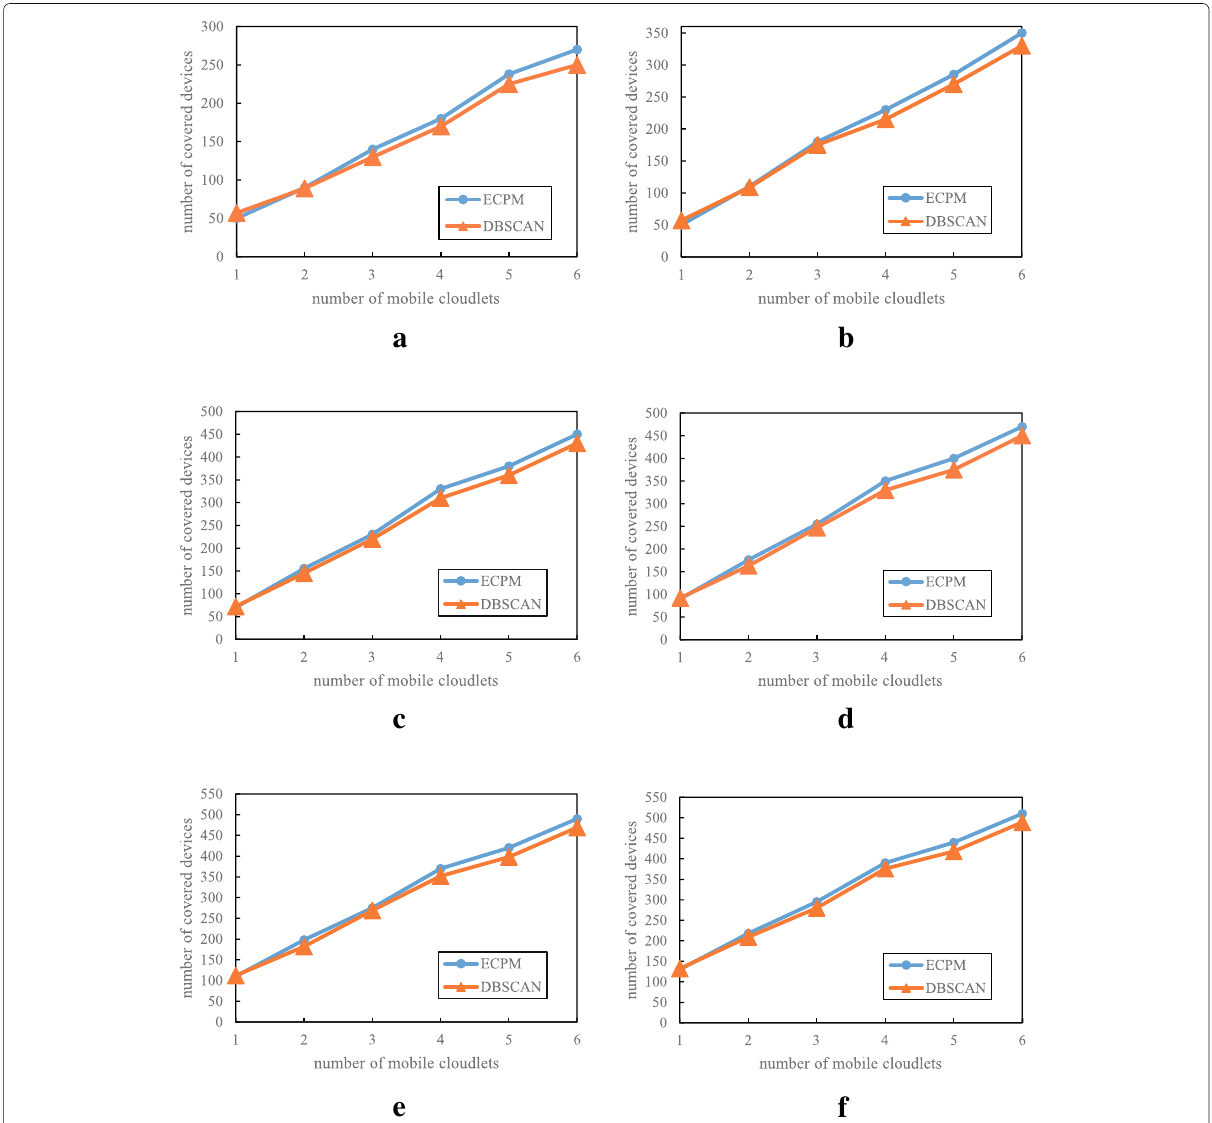
Fig. 5 Comparison of the covering equipment between the ECPM and DBSCAN. a 300 mobile devices. b 400 mobile devices. c 500 mobile devices. d 600 mobile devices. e 700 mobile devices. f 800 mobile